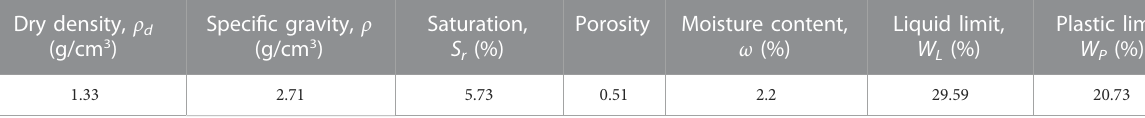
TABLE 1 Physical property indices of the intact loess. Dry density, ρ